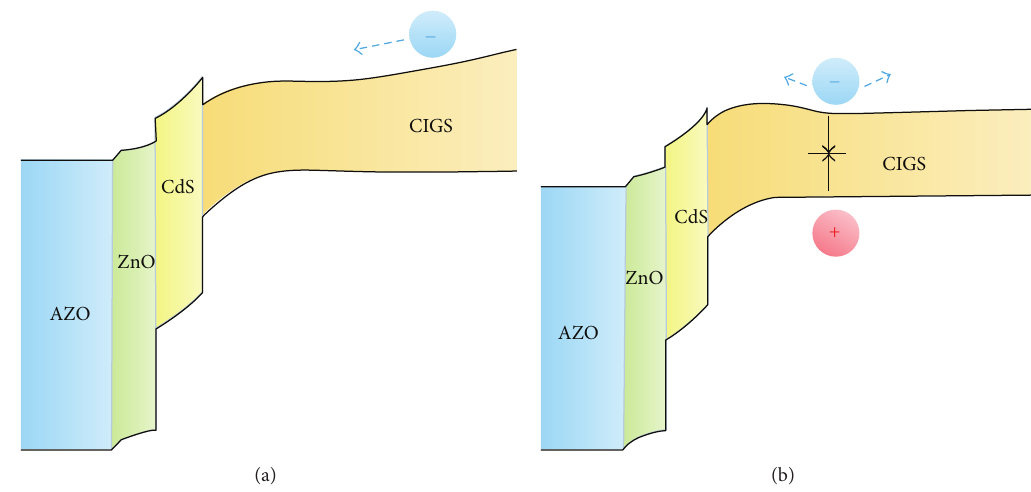
Figure 4: The band diagrams of CIGS solar cells with the cases (a) positive Δ Eg BF and (b) negative Δ Eg BF .